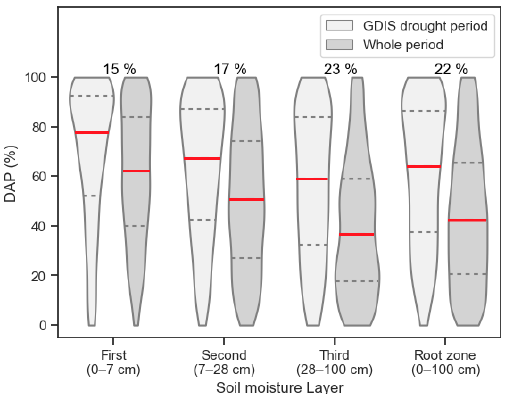
Figure 3. Comparison of DAP between the GDIS drought period and the whole period. The red line shows the median value, and grey dotted lines show the 25th and 75th percentile values of each distribution. The value above the violin plot shows the difference in the median values in the GDIS drought period and the whole period.